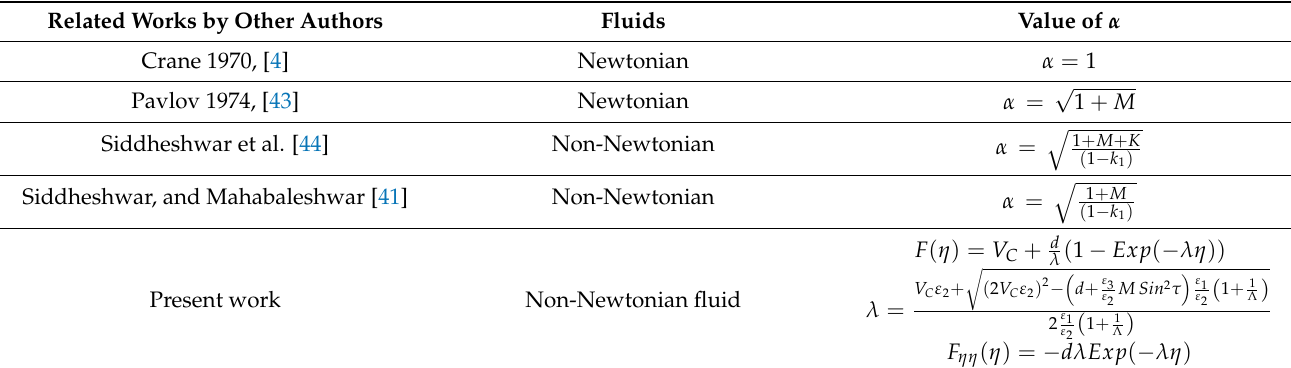
Table 3. Comparison of present study and related works by other